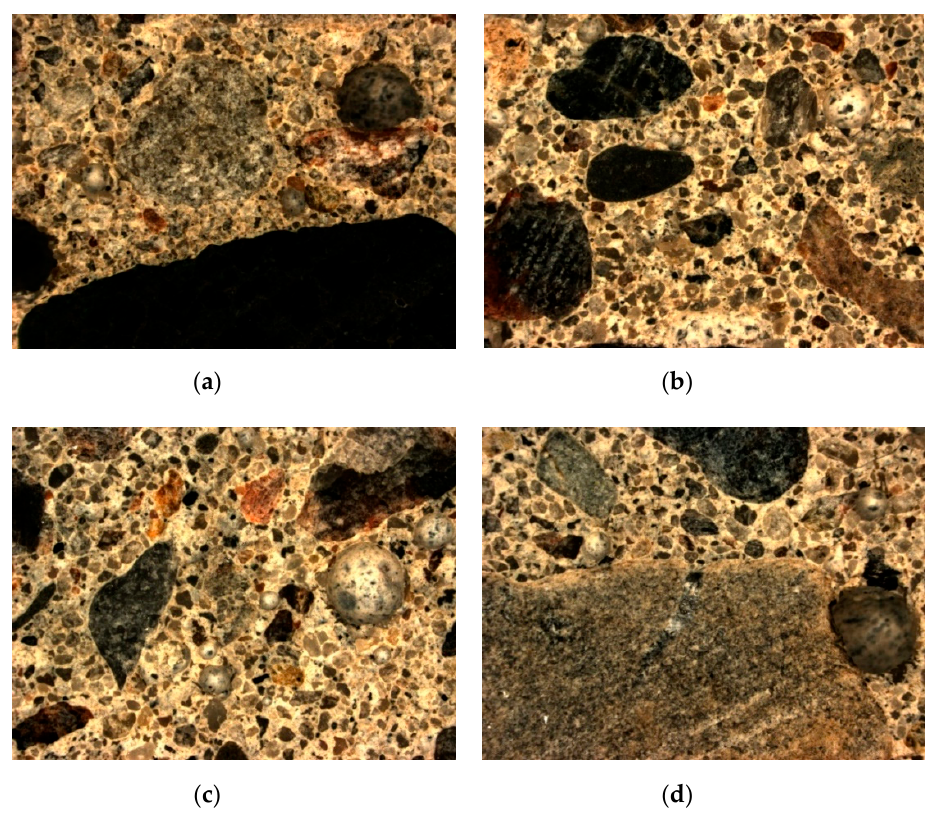
Figure 6. The image of the tested concrete samples after cutting: ( a ) PW5, ( b ) PW7, ( c ) PW8 and ( d ) PW9. Table 6. The average values of the parameters characterizing air voids and their